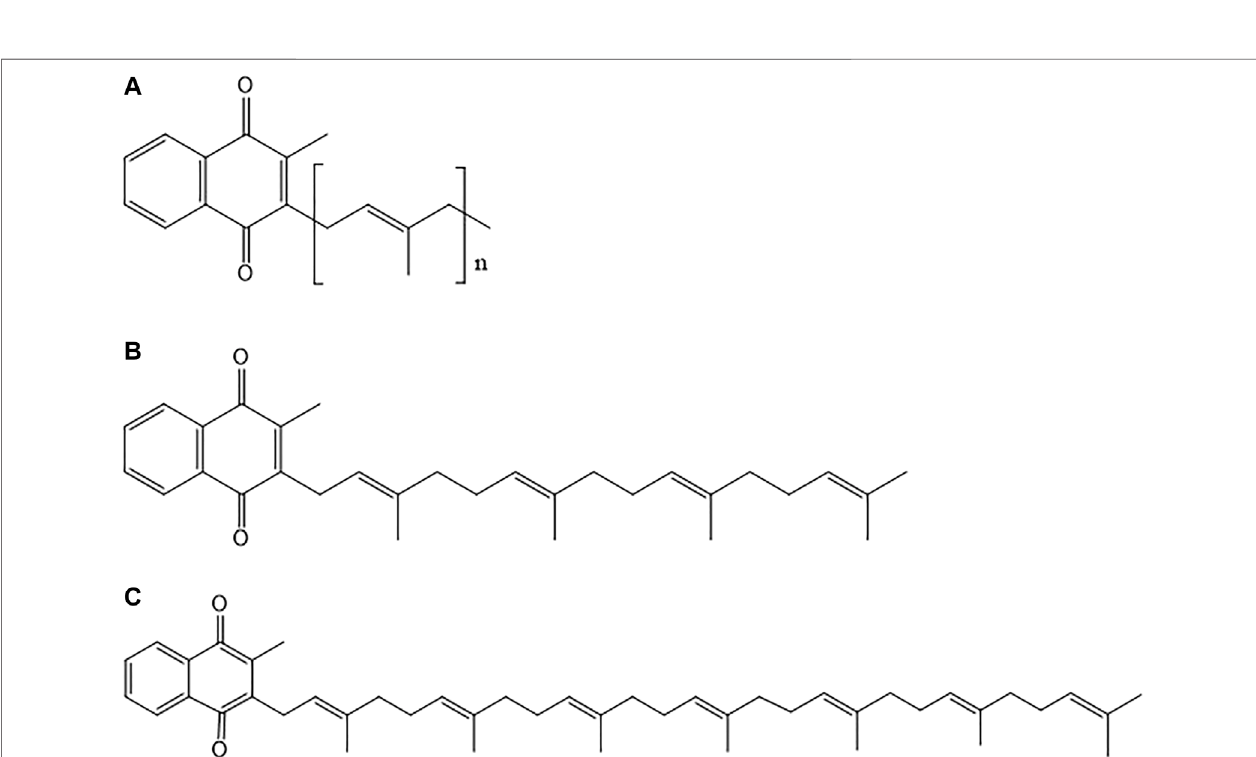
FIGURE 2 | (A) General chemical structure of vitamin K2 family; (B) Chemical structure of menaquinone-4 (MK-4); and (C) Chemical structure of menaquinone-7 (MK-7).